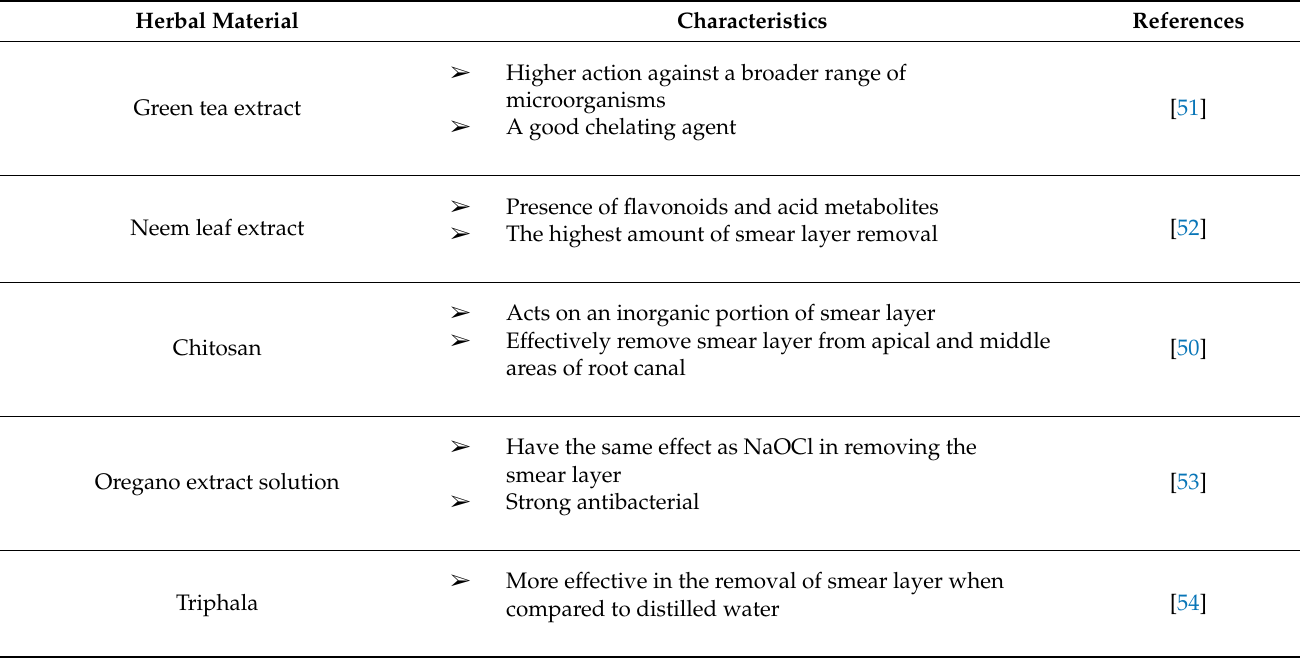
Table 4. Studies related to the use of herbal medicine for removal of smear